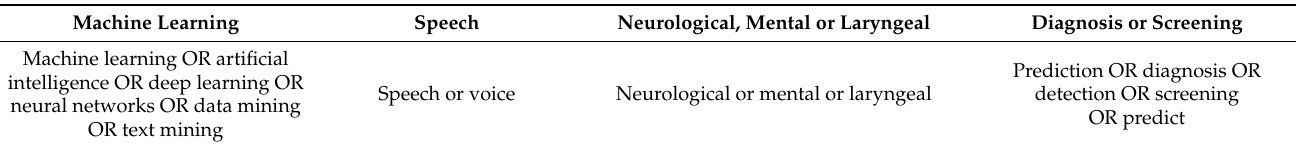
Table 1. The terms below show the search strategy used in this research. Each term consists of MeSH terms and synonyms.